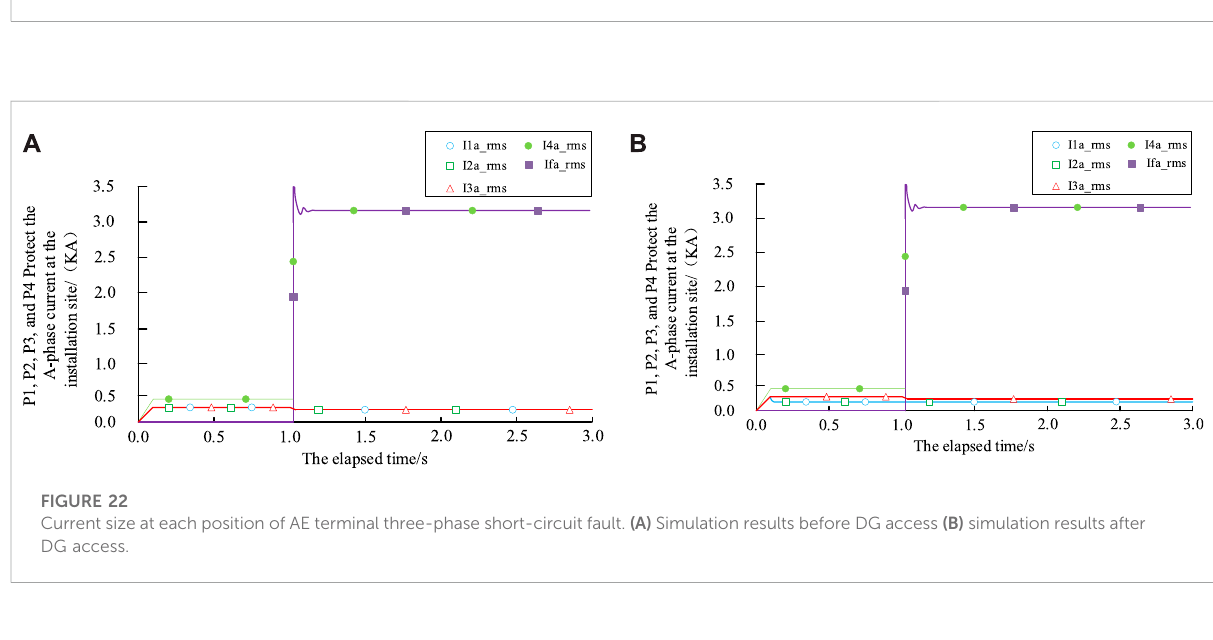
FIGURE 21 Three-stage protection action logic when three-phase short circuit fault occurs at the end of line CD. (A) Simulation results before DG access (B) simulation results after DG access.